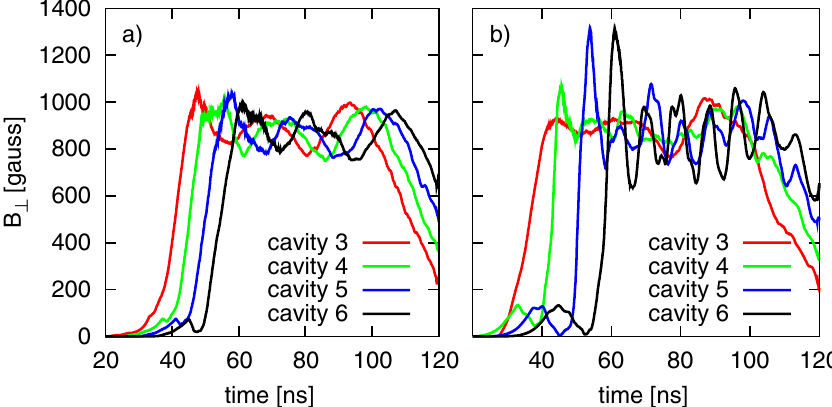
FIG. 11. (Color) Simulated B -field probes in IVA cells 3–6 for (a) cell firings spaced 3.3 ns apart (nominal timing) and (b) cell firings spaced 7.7, 4.7, and 4.6 ns apart for cells 3–6, respectively. Probes are located 180 degrees from the radial feed.